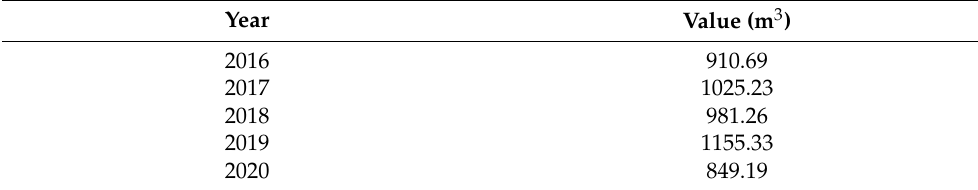
Table 3. Average influent flow per